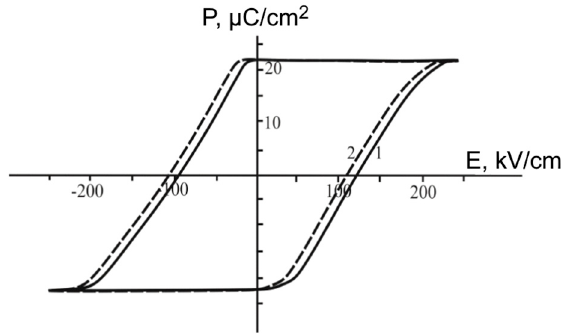
Figure 9. Dielectric hysteresis loop for BaZrO 3 /BaTiO 3 superlattice at the temperature of 20 ° С : 1— without internal bias field, 2—with additionally applied field.